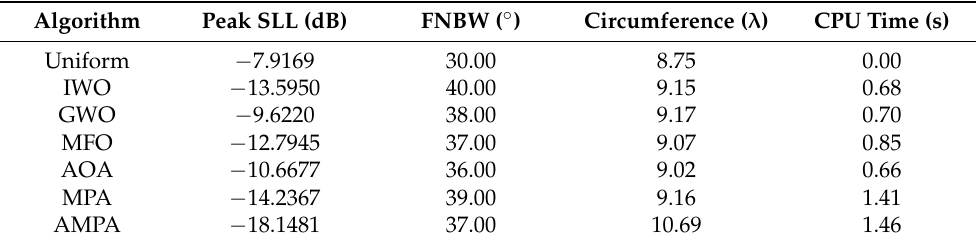
Figure 6. 12 − element CAA. ( a ) Radiation patterns obtained by different algorithms for reducing the PSLL. ( b ) Convergence rates of different algorithms for reducing the PSLL. Table 8. Optimization results of 18-element CAA obtained by different algorithms for PSLL